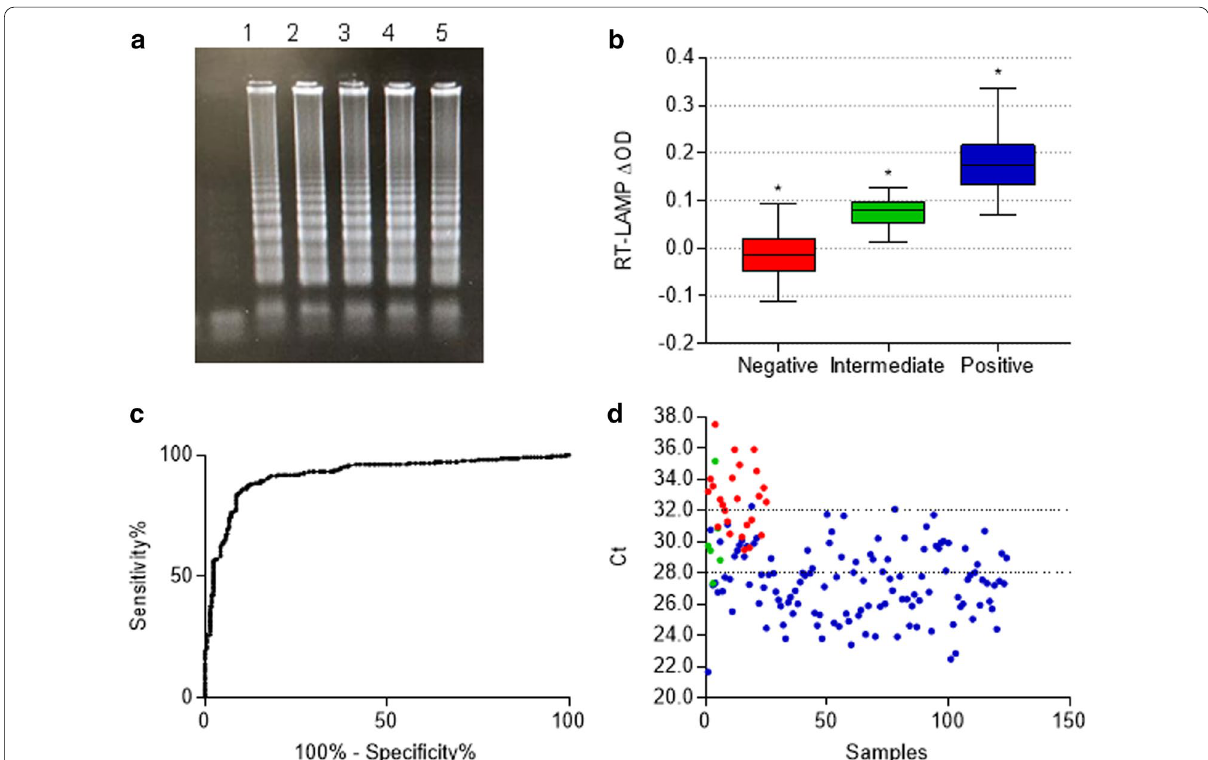
Fig. 2 RT-LAMP validation results. a Electrophoresis of RT-LAMP products. RT-LAMP reaction products were analyzed on a 2% agarose gel and the DNA was stained with ethidium bromide. The typical band pattern of a RT-LAMP reaction was visible in positive samples that showed a color change from pink to yellow. Lane 1 NTC and lanes 2–6 positive samples. b Colorimetric readout after 30 min of RT-LAMP reaction. After the = = reaction, the optical densities were measured at 434 nm and 560 nm using a BioteK Synergy reader. To obtain the Δ OD (color change difference), the absorbance at 560 nm was subtracted from the one at 434 nm. The line inside the box indicates the median and the whiskers extend either to the minimum and maximum values. * Indicates difference (p > 0.001) between groups (unpaired, t-test). c Receiver Operating Characteristic (ROC) curve for SARS-CoV-2 colorimetric RT-LAMP with area under the curve of 0.92 ( p < 0.0001) and 95% confidence interval (CI) 0.8924 to 0.9483. d Detection of SARS-CoV-2 through colorimetric RT-LAMP assay and comparison between colorimetric RT-LAMP results and RT-qPCR Ct values. Between the dotted lines is a conflicted area where most of the intermediate samples are found